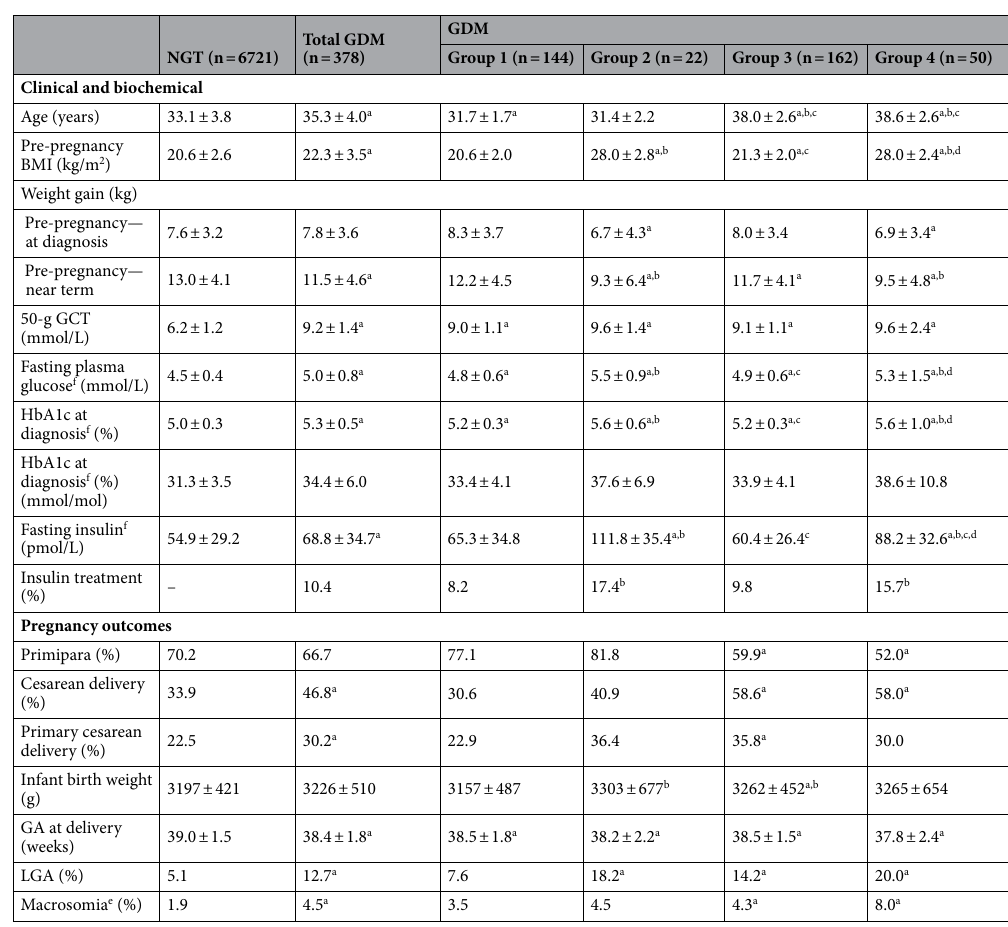
Table 1. Clinical and biochemical characteristics and pregnancy outcomes of NGT and GDM subjects according to maternal age and pre-pregnancy BMI. NGT normal glucose tolerance, GDM gestational diabetes mellitus, BMI body mass index, GCT glucose challenge test, HbA1c glycosylated hemoglobin, GA gestational age, LGA large for gestational age; GDM group 1 (age < 35 years and BMI < 25 kg/m 2 ); group 2 (age < 35 years and BMI ≥ 25 kg/m 2 ); group 3 (age ≥ 35 years and BMI < 25 kg/m 2 ); group 4 (age ≥ 35 years and BMI ≥ 25 kg/ m 2 ). a p < 0.05, compared with NGT, b p < 0.05, compared with GDM group 1, c p < 0.05, compared with GDM group 2, d p < 0.05, compared with GDM group 3, e Infant birth weight ≥ 4 kg, f Column Ns for the variable are different from the Ns presented in the